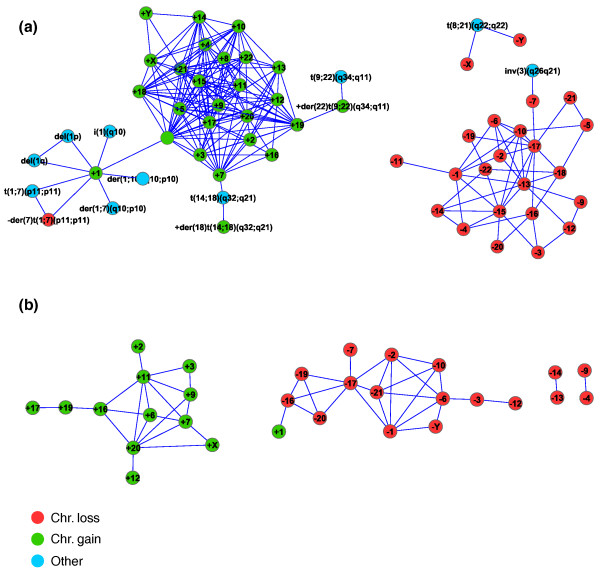
Highly co-occurring aberration pairs. Highly co-occurring aberrations in the entire karyotype dataset are connected by lines. Aberrations that are involved only in expected links (for example, a link between a translocation and a gain/loss of one of its derivative chromosomes; a link between two (two-break) translocations originating from one three-break [18] rearrangement) are not shown. For explanations of aberration names, see Additional file 1. (a) Highly co-occurring pairs in the Mitelman Database karyotypes (links are significant at P < 0.05, after Bonferroni correction). (b) Highly co-occurring pairs in the comparative genomic hybridization dataset (links are significant at FDR 5%). The only gain-loss link is (+1, -16), which has the second worst (that is, highest) P-value among the 47 pairs that passed the FDR 5% criterion. The figure was drawn using Cytoscape [40].